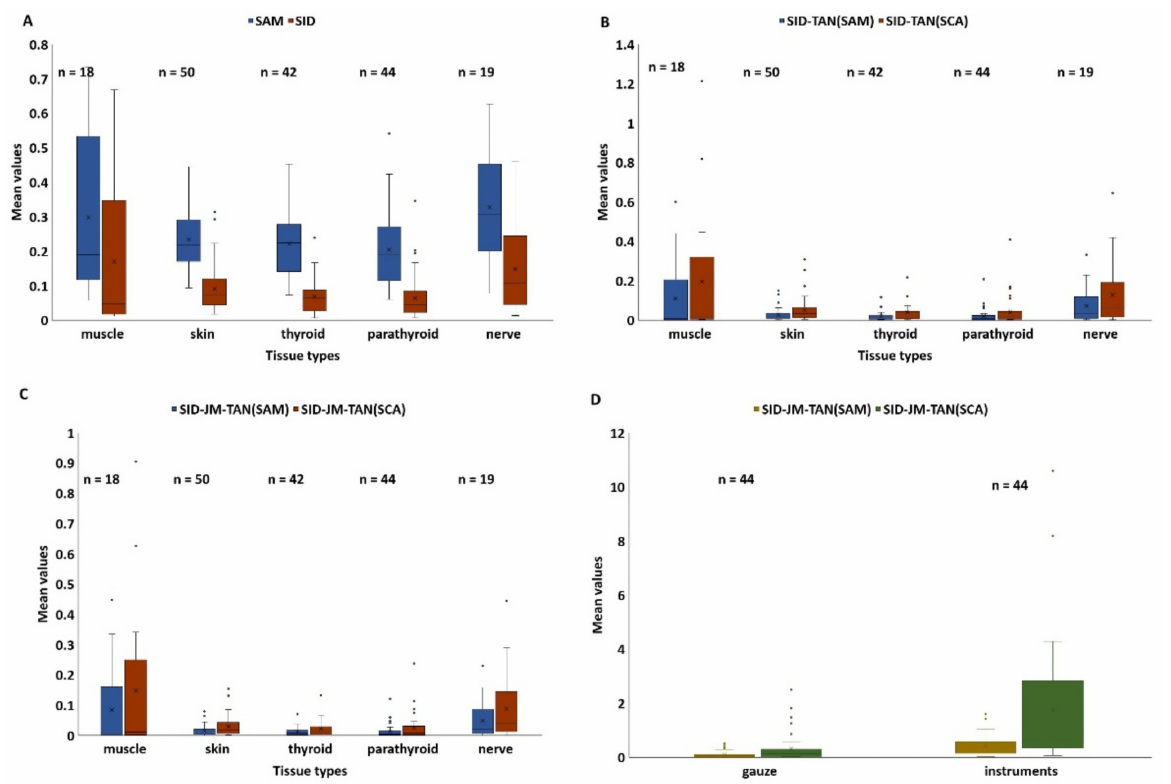
Figure 3. Averaged similarity values calculated for thyroid as reference versus muscle, nerve, parathyroid, thyroid, gauze, and instruments (( A ) SAM and SID measures; ( B ) SID-TAN(SAM) and SID-TAN(SCA) measures; ( C ) SID-JM-TAN(SAM) and SID-JM-TAN(SCA) measures; ( D ) SID-JM- TAN(SAM) and SID-JM-TAN(SCA) for gauze and instruments against thyroid); n is the number of